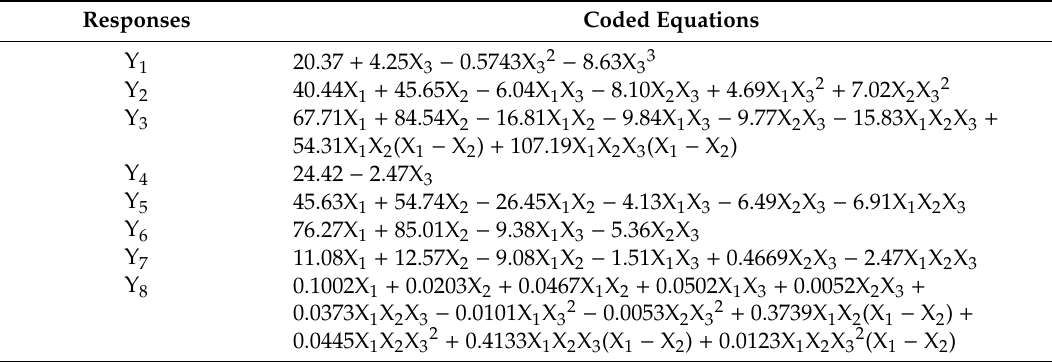
Table 4. Coded equations of responses according to factors.